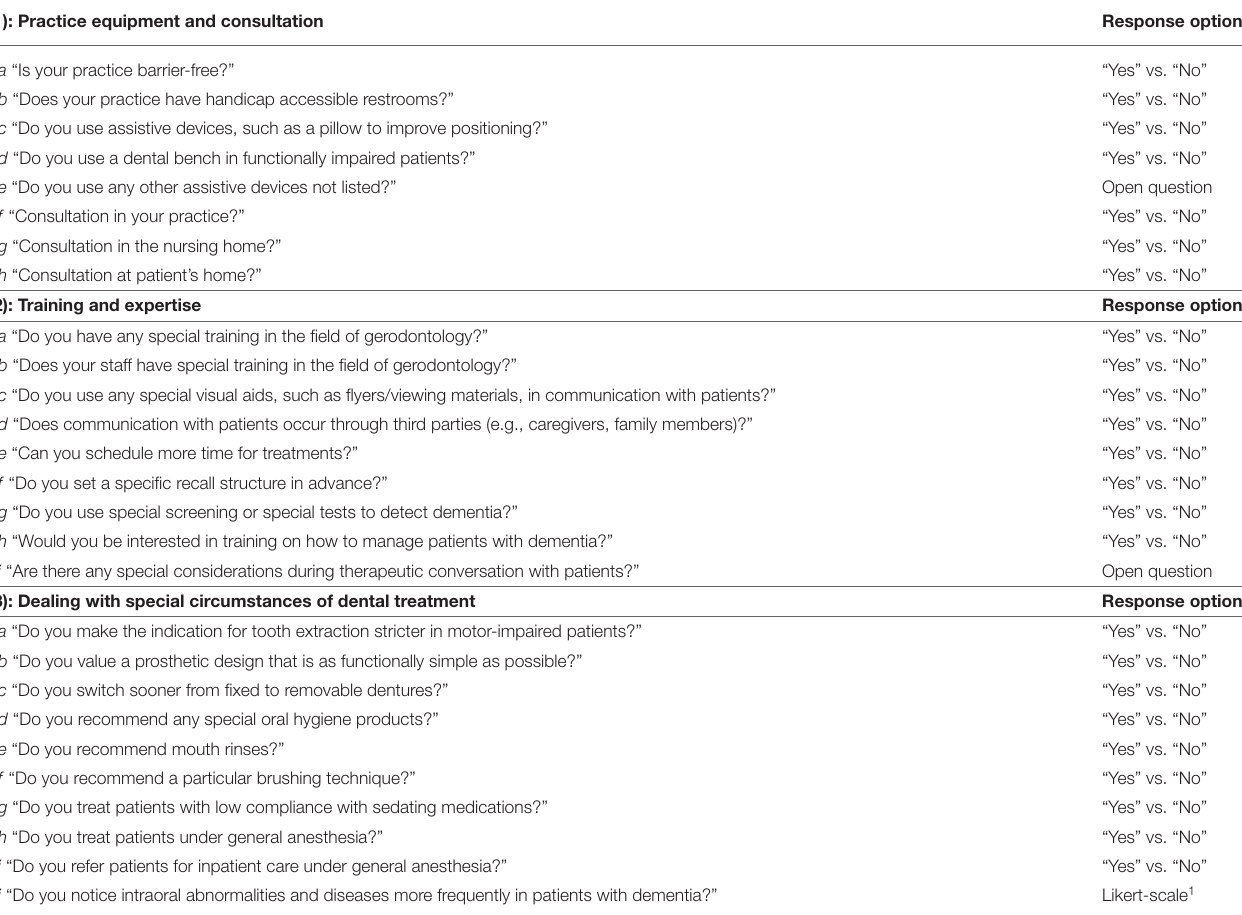
TABLE 1 | Questionnaire-items about patients with